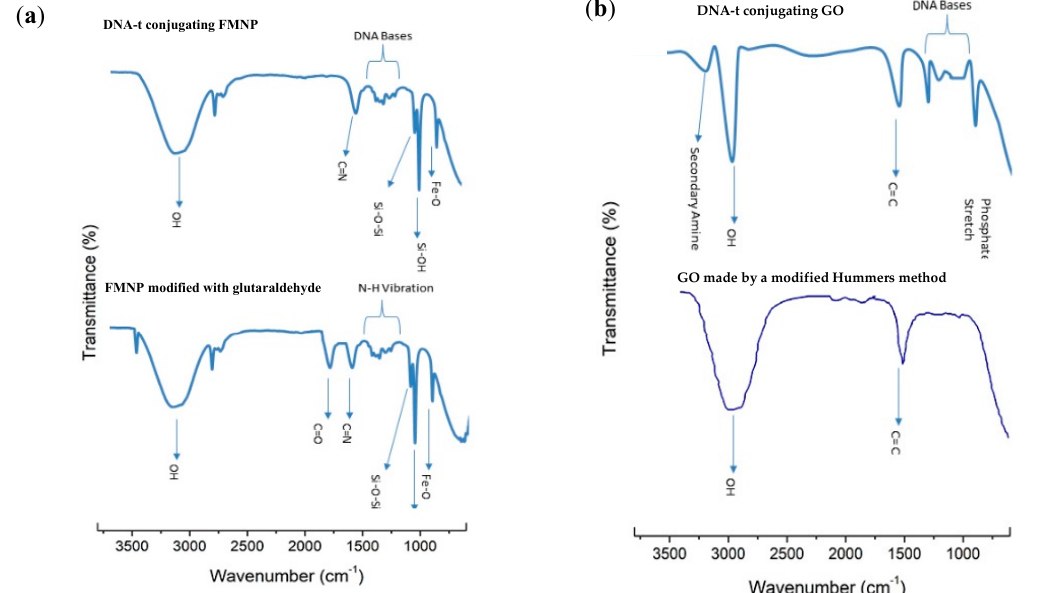
Figure 6. FTIR spectra ( a ) FMNPs conjugating with glutaraldehyde, and DNA-t modified. FMNPs, ( b ) graphene oxide (GO) nanosheet, and DNA-c-modified with GO.